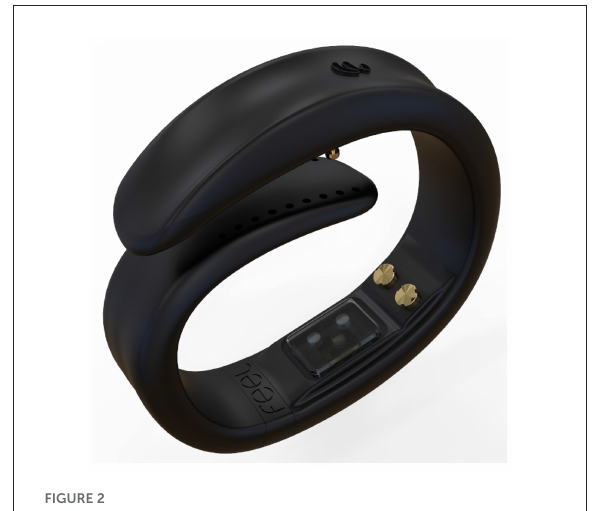
FIGURE2 The Feel Emotion Sensor